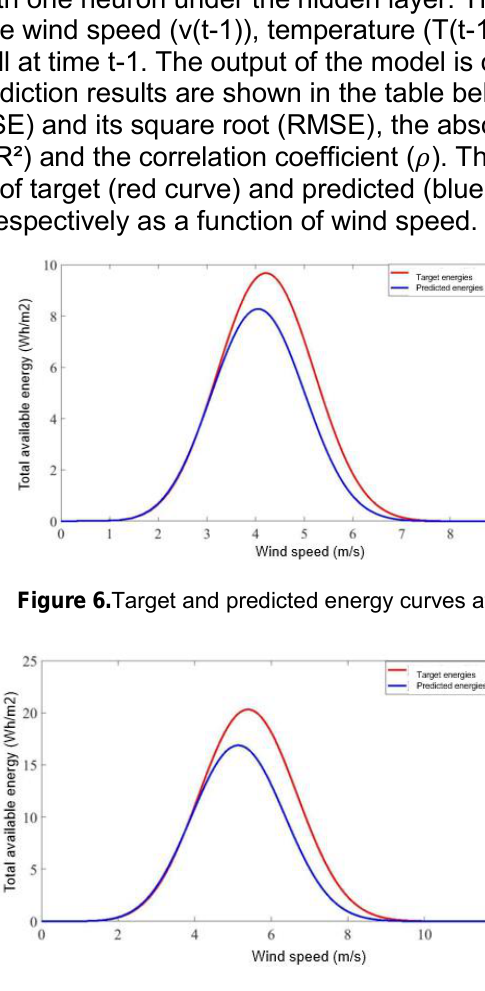
Figure 7. Target and predicted energy curves at 50m